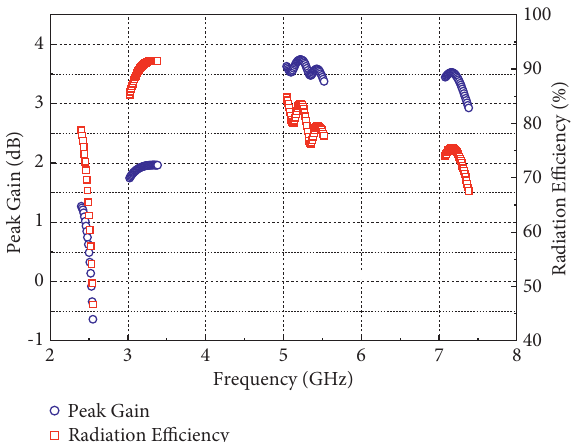
Figure 8: Gain and efficiency of the proposed antenna.